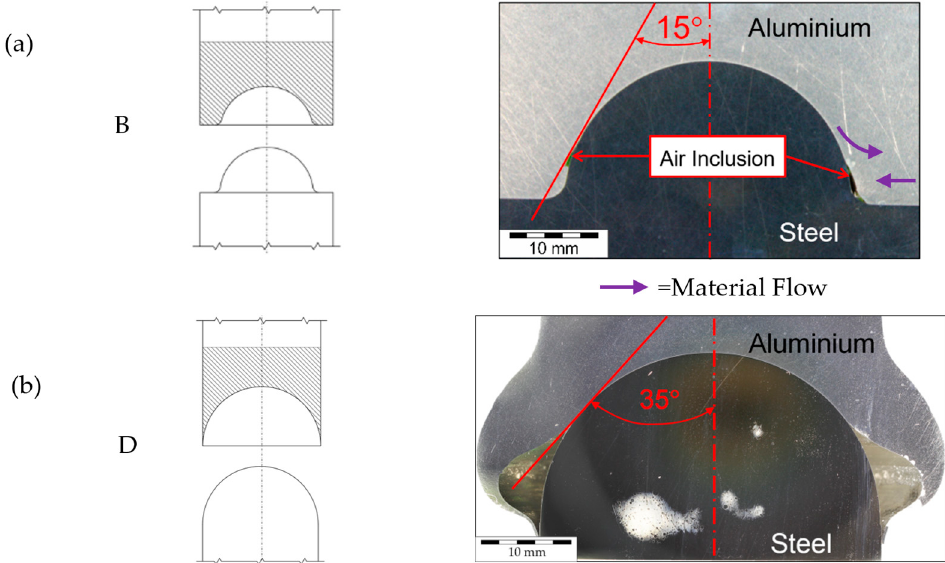
Figure 7. ( a ) Cross section of Geometry B and ( b ) cross section of Geometry D; the angles mark the detachment of the aluminum.